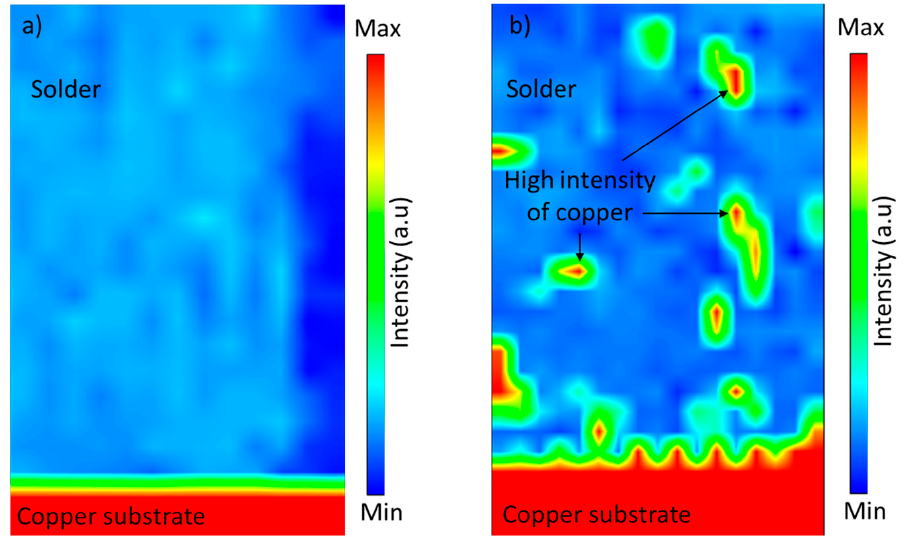
Figure 10. Synchrotron micro-XRF results from Cu mapping distribution of ( a ) non-textured copper